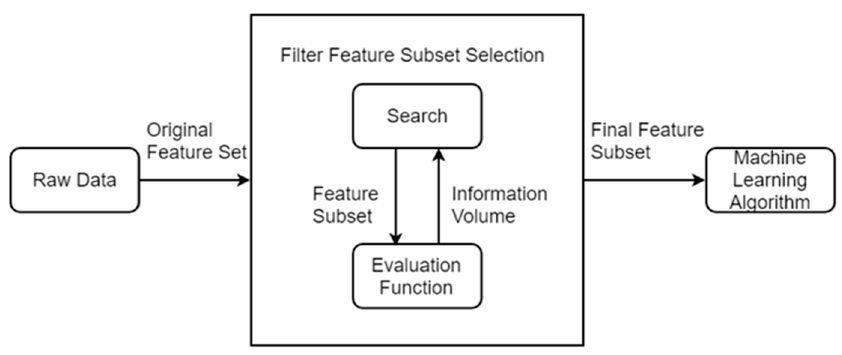
Figure 5. Filtered feature selection algorithm.